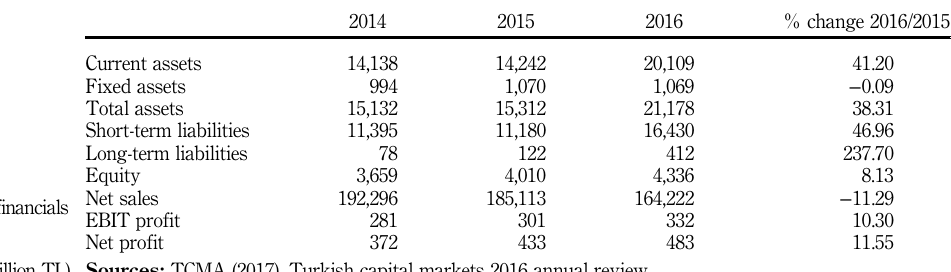
Table II. Fundamental financials